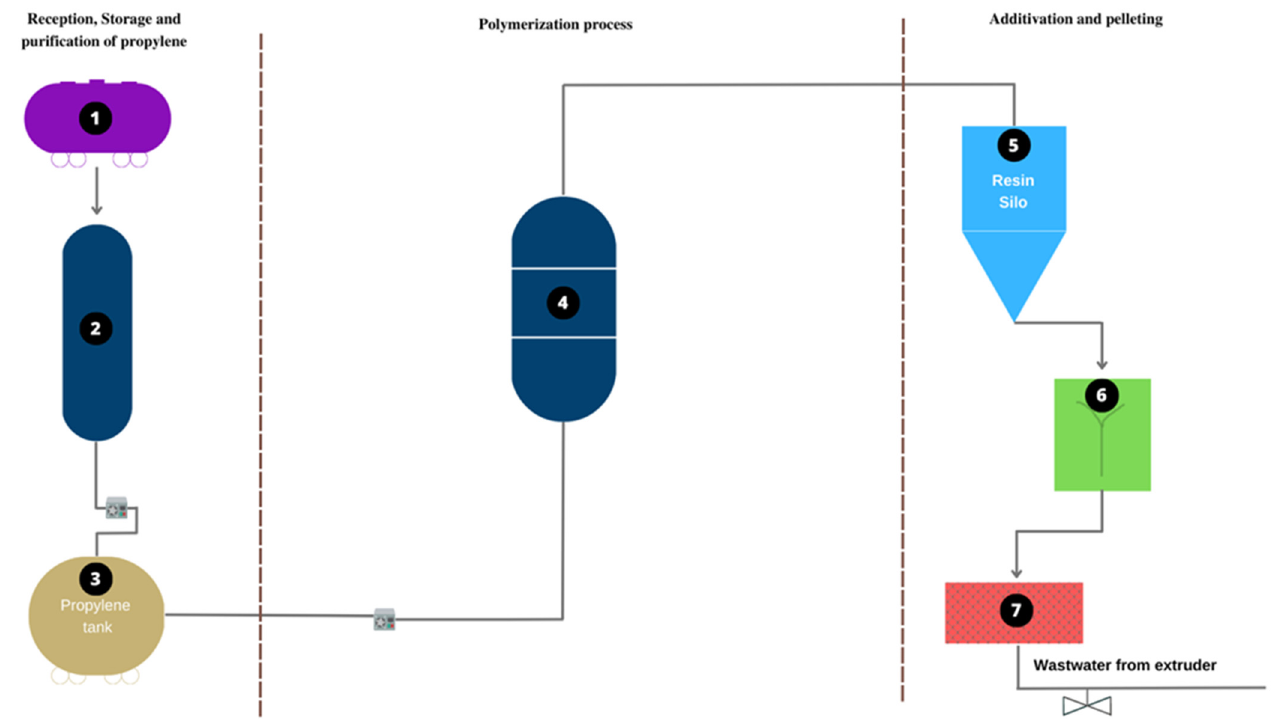
Figure 10. Flowchart of the plant from which the samples were taken.